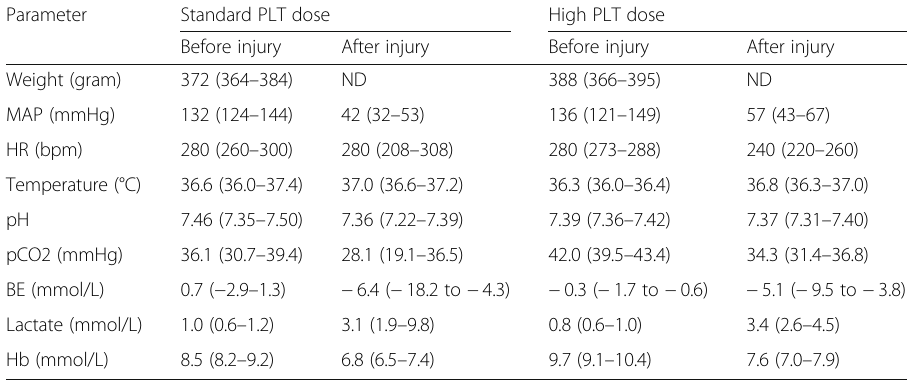
Table 1 Vital parameters at baseline and after induction of injury Parameter Standard PLT dose